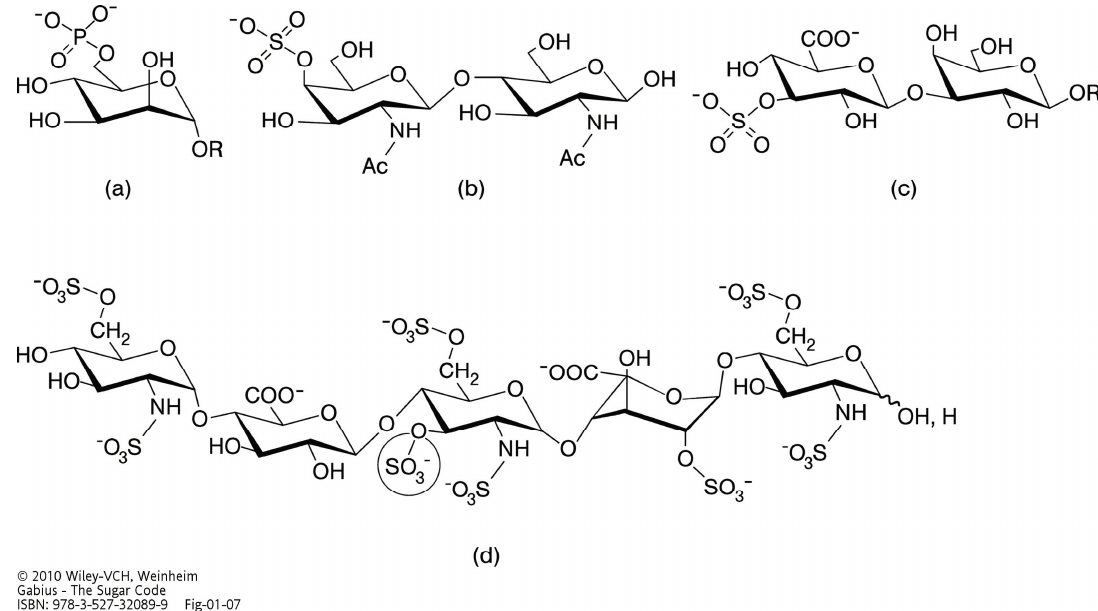
Figure 2. Illustration of phosphorylated (phosphated) and sulfated (sulfurylated) glycan “words”. 6-Phosphorylation of a mannose moiety (in the context of a pentamannoside) is the key section of a routing signal (“read” by P-type lectins) in lysosomal enzymes ( a ), 4-sulfation of the GalNAc β 1,4GlcNAc (LacdiNAc) epitope forms the “postal code” for clearance of pituitary glycoprotein hormones from circulation by a hepatic endothelial cell receptor, a bifunctional lectin with C-type and β -trefoil domains ( b ), the HNK (human natural killer)-1 epitope (CD57, 3-sulfated GlcA β 1,3Gal β 1,4GlcNAc) is involved in